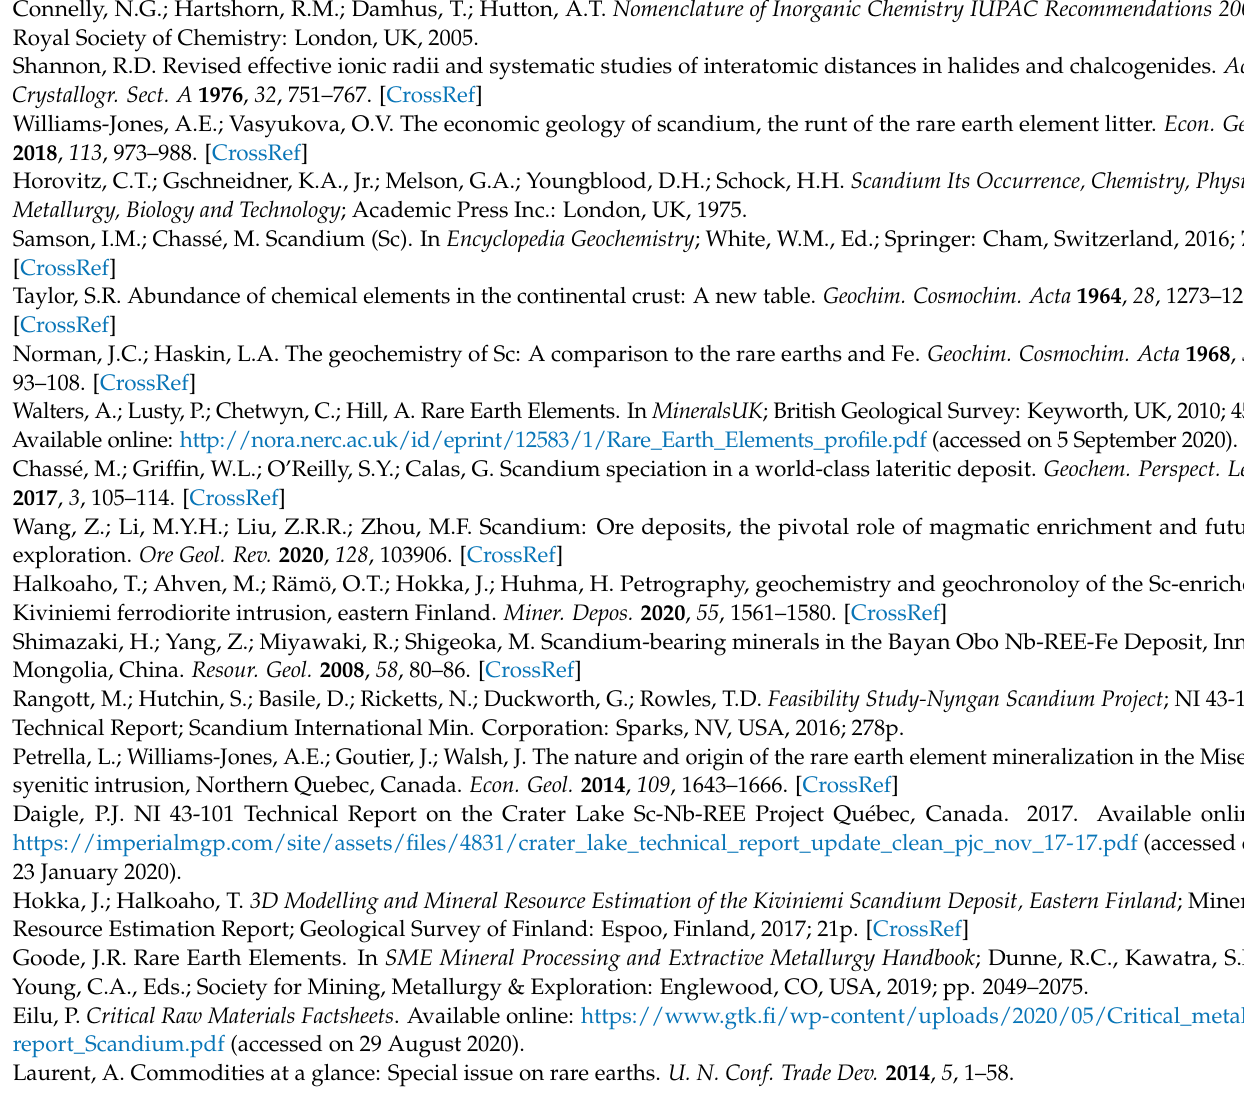
data, Table S2: EPMA standards and detection limits, Table S3: Amphibole and clinopyroxene grain size data, Table S4: Modal mineralogy data, Table S5a–d: Amphibole and clinopyroxene liberation data, Table S6: EPMA